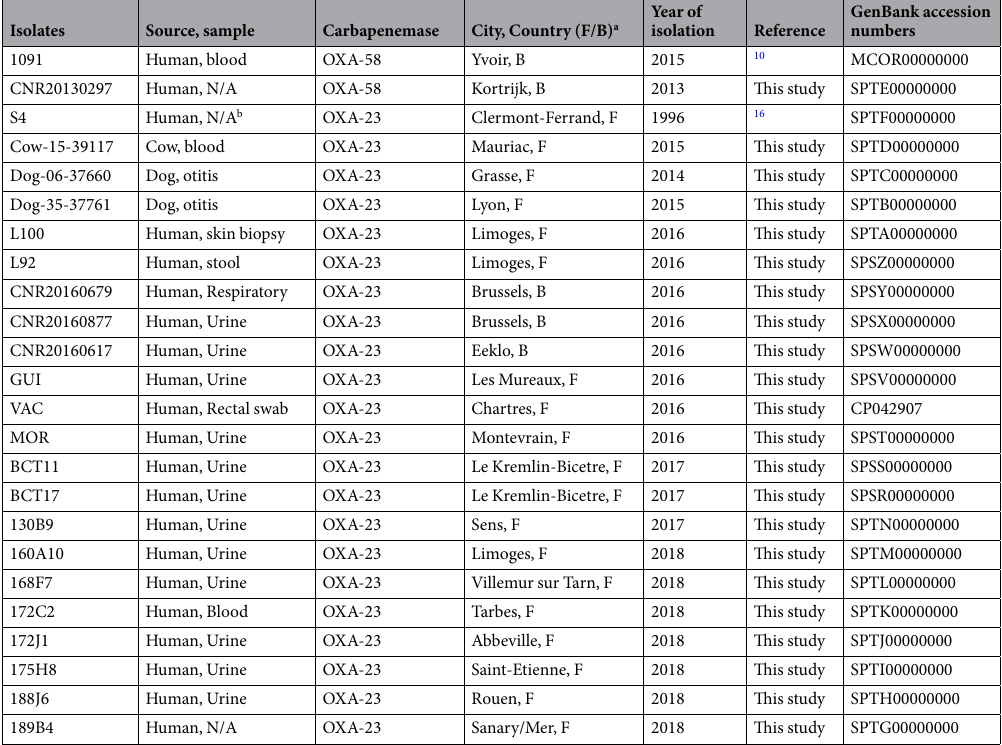
Table 1. Clinical features of OXA-23 or OXA-58-producing P. mirabilis isolates. a F: France, and B: Belgium b